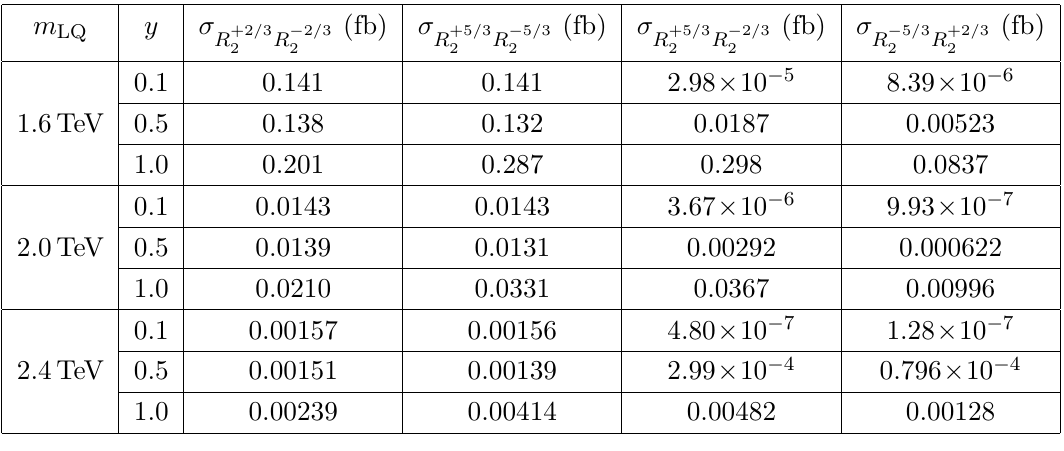
Table 4 . The leading order cross sections for the leptoquark pair production for the R 2 scenario in the proton-proton collisions at 13 TeV center-of-mass energy when the R m LQ couple exclusively to a right-chiral leptons and the first generation quarks, as allowed by the SM gauge group, with the coupling strength y ≡ y LR